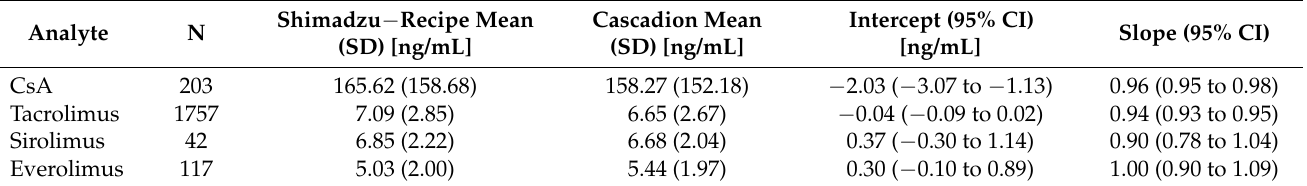
Figure 2. Passing − Bablok fit (red line) for cyclosporine A ( A ), tacrolimus ( B ), sirolimus ( C ), and everolimus ( D ). Grey line indicates the perfect correlation (slope = 1, intercept = 0). Each plot is coupled to regression results. Table 6. For each analyte, mean (standard deviation) and Passing–Bablok regression parameters are shown both for the reference and test